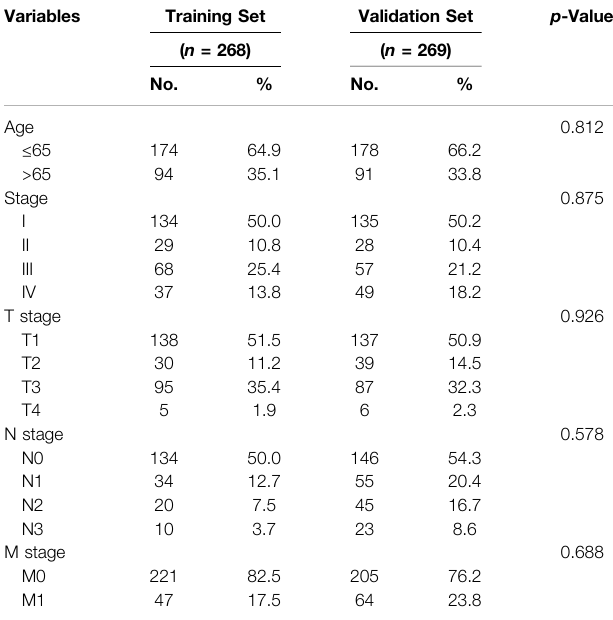
TABLE 1| The associationbetweenriskscoreand patients ’ clinical features inthe training set. Variables Training Set Validation